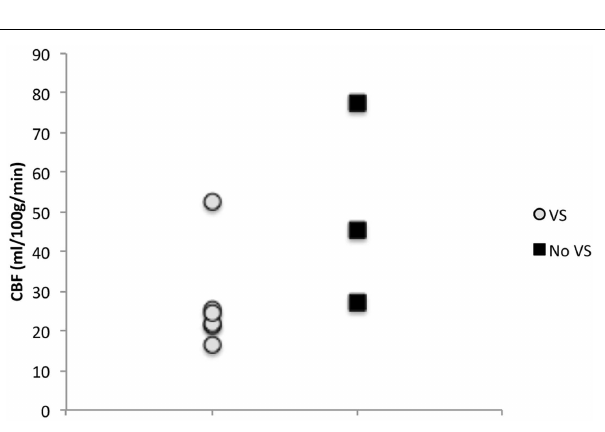
FIGURE 4 | Six out of nine patients developed DCI while three did not . Patients that did not develop DCI tended to have higher initial CBF than patients who did develop